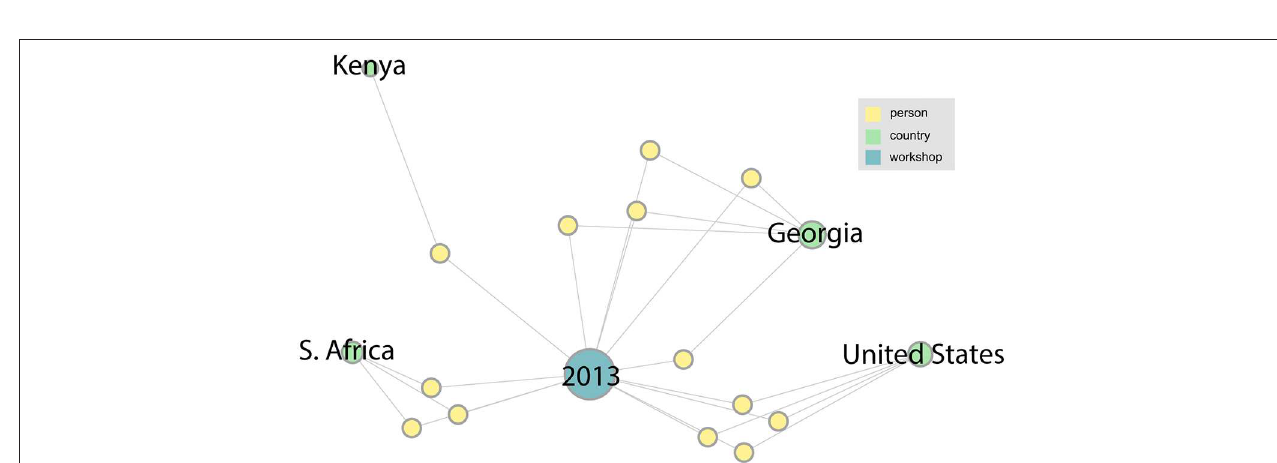
FIGURE 3 | The network associated with the LANL 2013 sequencing workshop. In this figure and the ones to follow, information about persons (yellow nodes) has been anonymized by leaving them unlabeled.